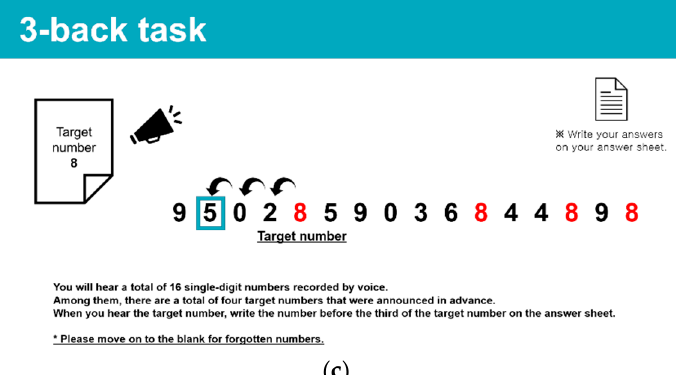
Figure 1. An example STM/WM Task trial: ( a ) Corsi block-tapping, ( b ) Digit span, and ( c ) 3-back.